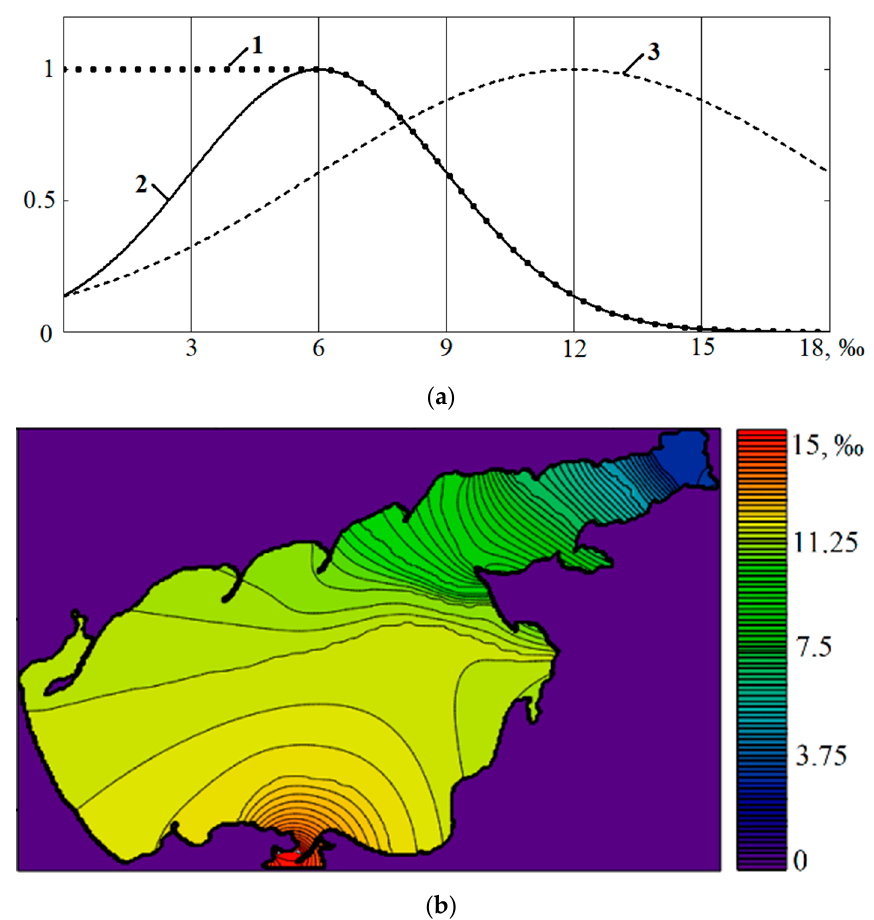
Figure 4. The salinity influence on the phytoplankton growth: ( a ) graphs of the growth rate of 1—green, 2—blue-green, 3—diatoms on salinity; ( b ) reconstructed salinity field.